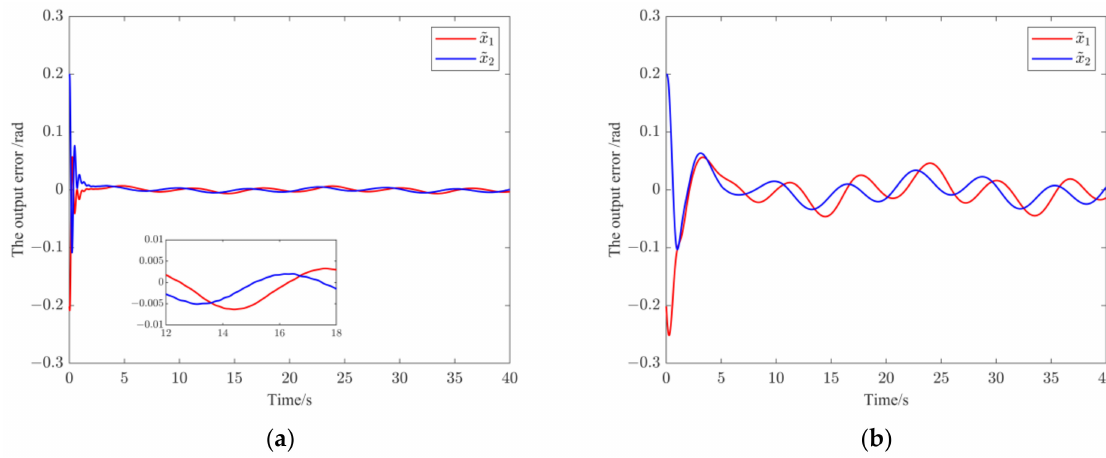
( a ) RBFTHC, ( b ) CTC. θ